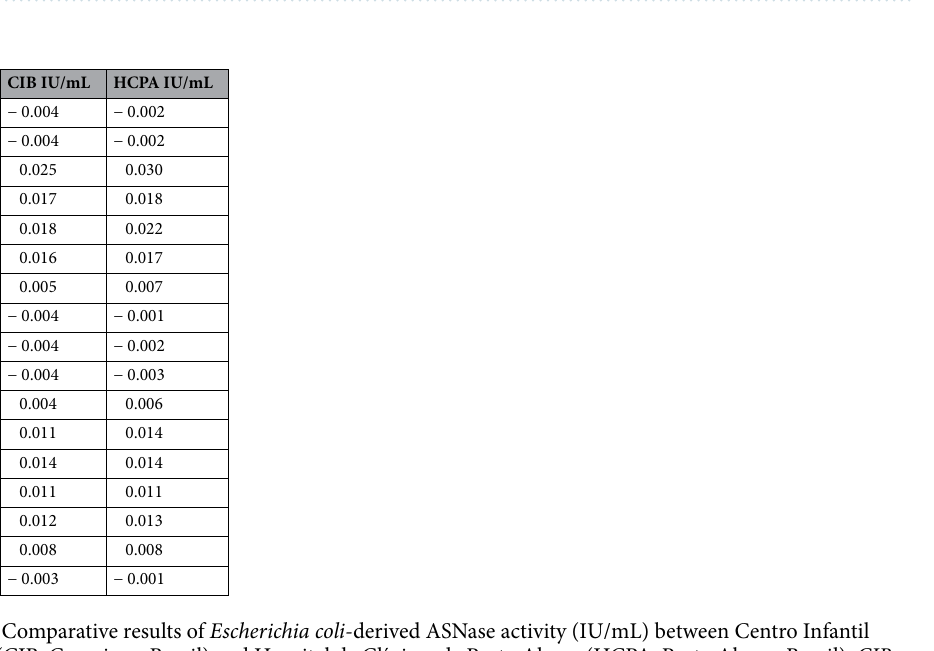
Table 1. Medians of enzyme activity evaluated at 24 h and 48 h after infusion. Data are presented as medians and interquartile ranges.